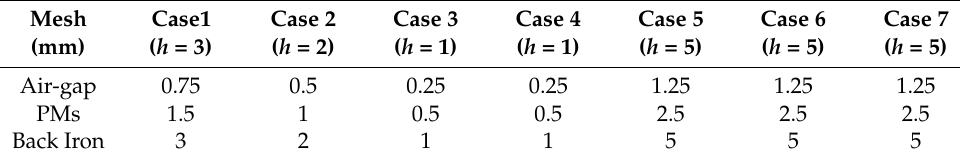
Table 4. Mesh-factor and Mash size values.